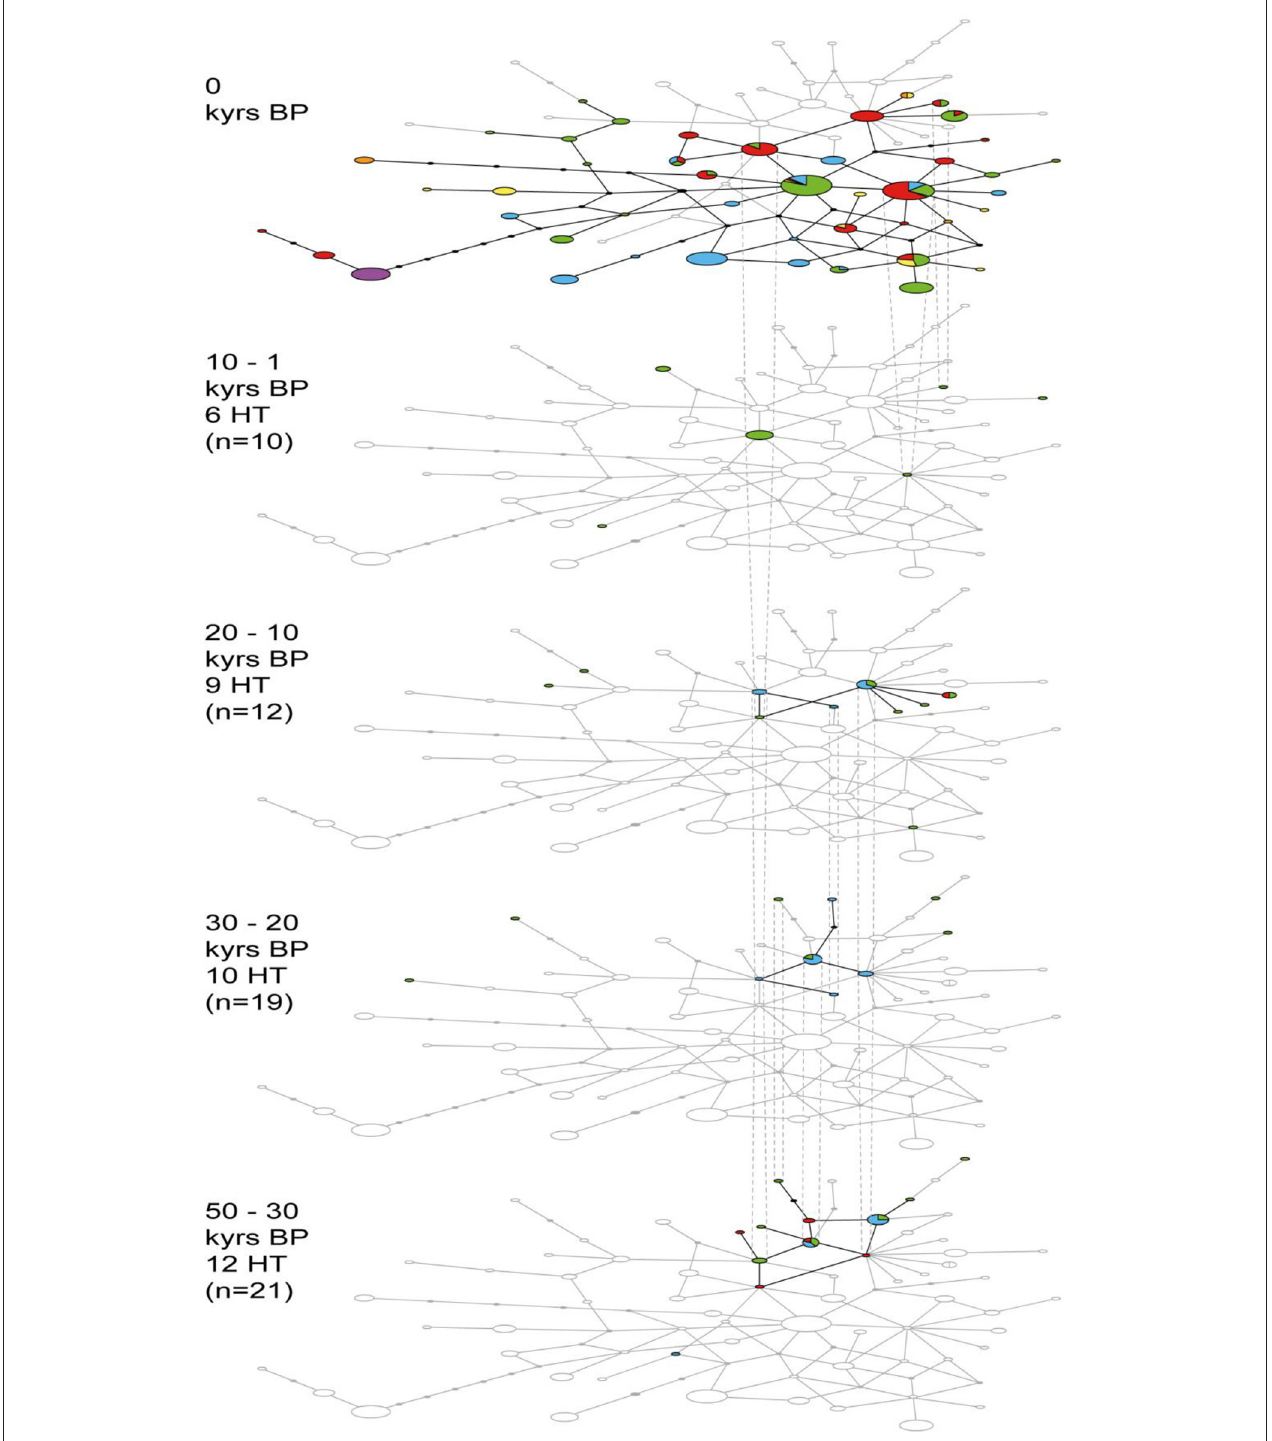
FIGURE 3 | Median joining network analysis for ancient wolf haplotypes (HT) identified for alignment C as well as all modern samples trimmed to match this alignment (excluding indels; 57bp). Temporal comparisons of five consecutive time periods are presented covering the Late Pleistocene and Holocene. Number of mutational steps is indicated by continuous lines, black ellipses represent missing haplotypes. Colors correspond to geographical region (see Figures 1 , 2 ).